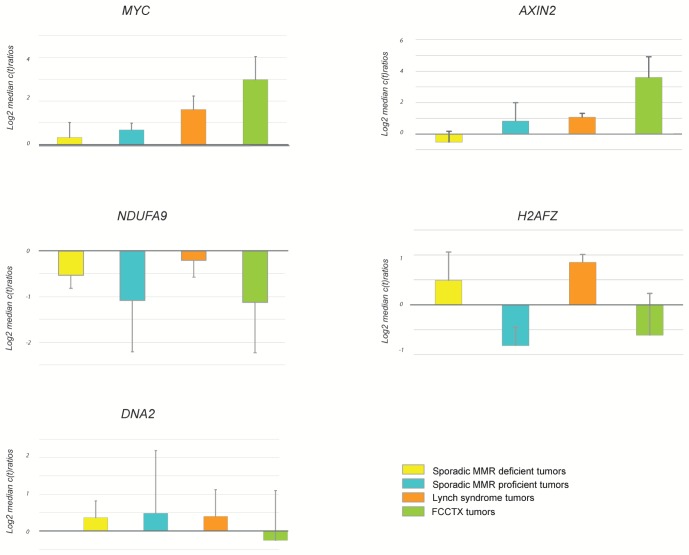
qRT-PCR analysis of 5 target genes in the four different colorectal cancer subsets.Differential expression of MYC, NDUFA9, H2AFZ, AXIN2, and DNA2 was done for 12 representative samples (3 from each group) and qRT-PCR ratios were normalized to rRNA18S and median centered.